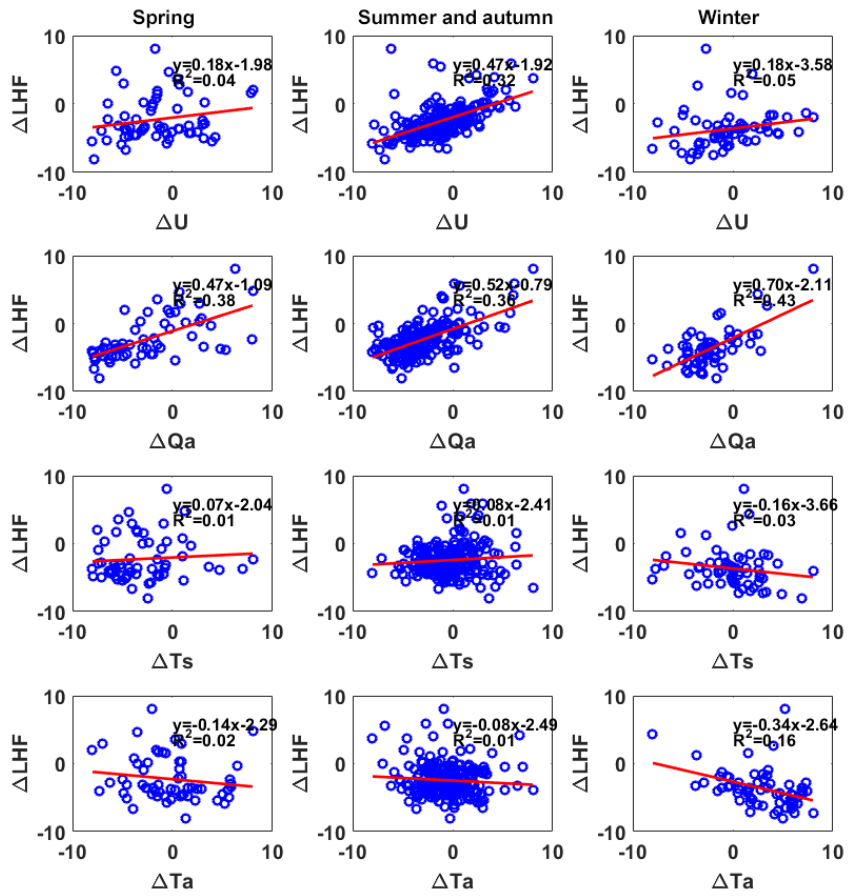
Figure 10. Scatter plots for the biases of U ( (cid:49)U ), Q a ( (cid:49)Q a ), T s ( (cid:49)T s ), and T a ( (cid:49)T a ) with respect to the biases of LHF ( (cid:49) LHF). All of the data are normalized to the range of − 10 to 10 in this paper. The linear regression equation and coefficient of determination ( R 2 ) are given in each panel. The solid red line refers to the linear regression of the matched